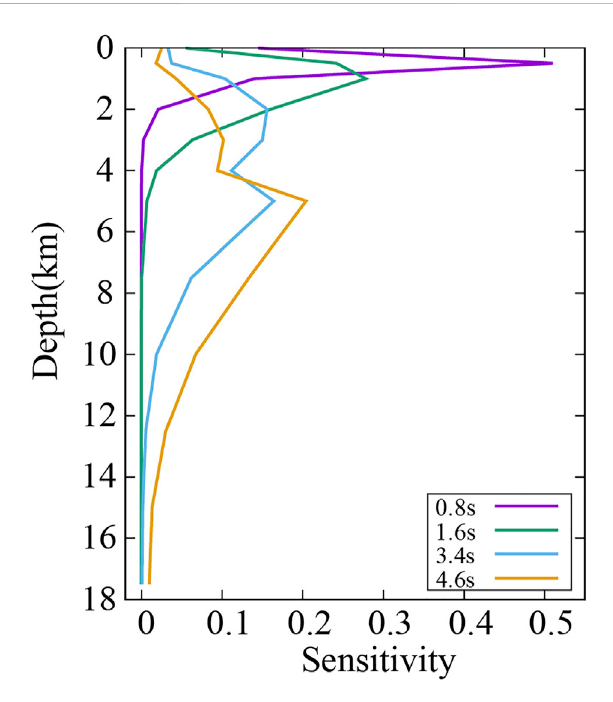
FIGURE 4 1-D depth sensitivity kernels to Vs. for the Rayleigh wave fundamental phase velocity at different periods using the average